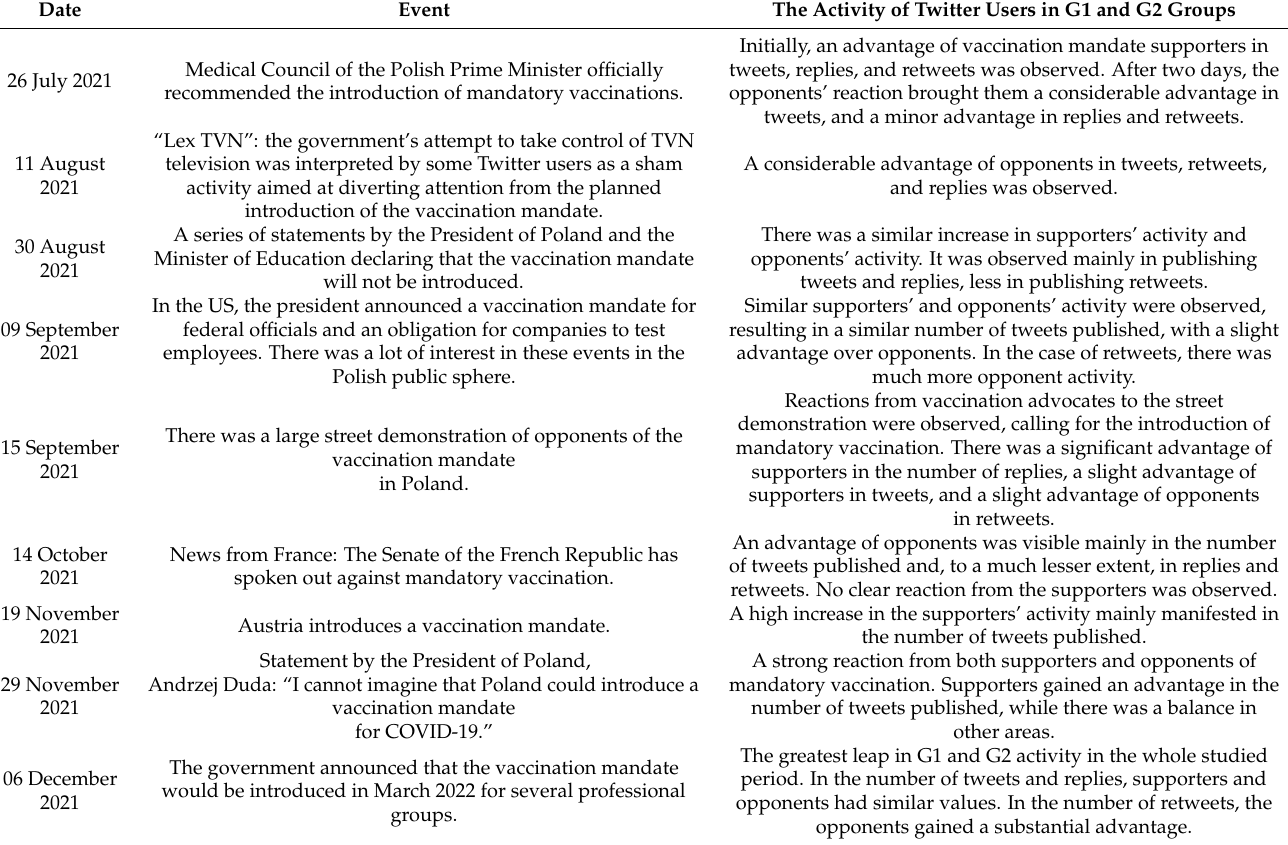
Table 3. Social and political events associated with tweets, retweets, and replies published in group G1 (opponents) and group G2